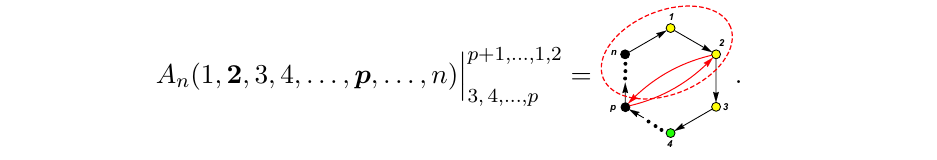
The dashed red line cuts more than four arrows.